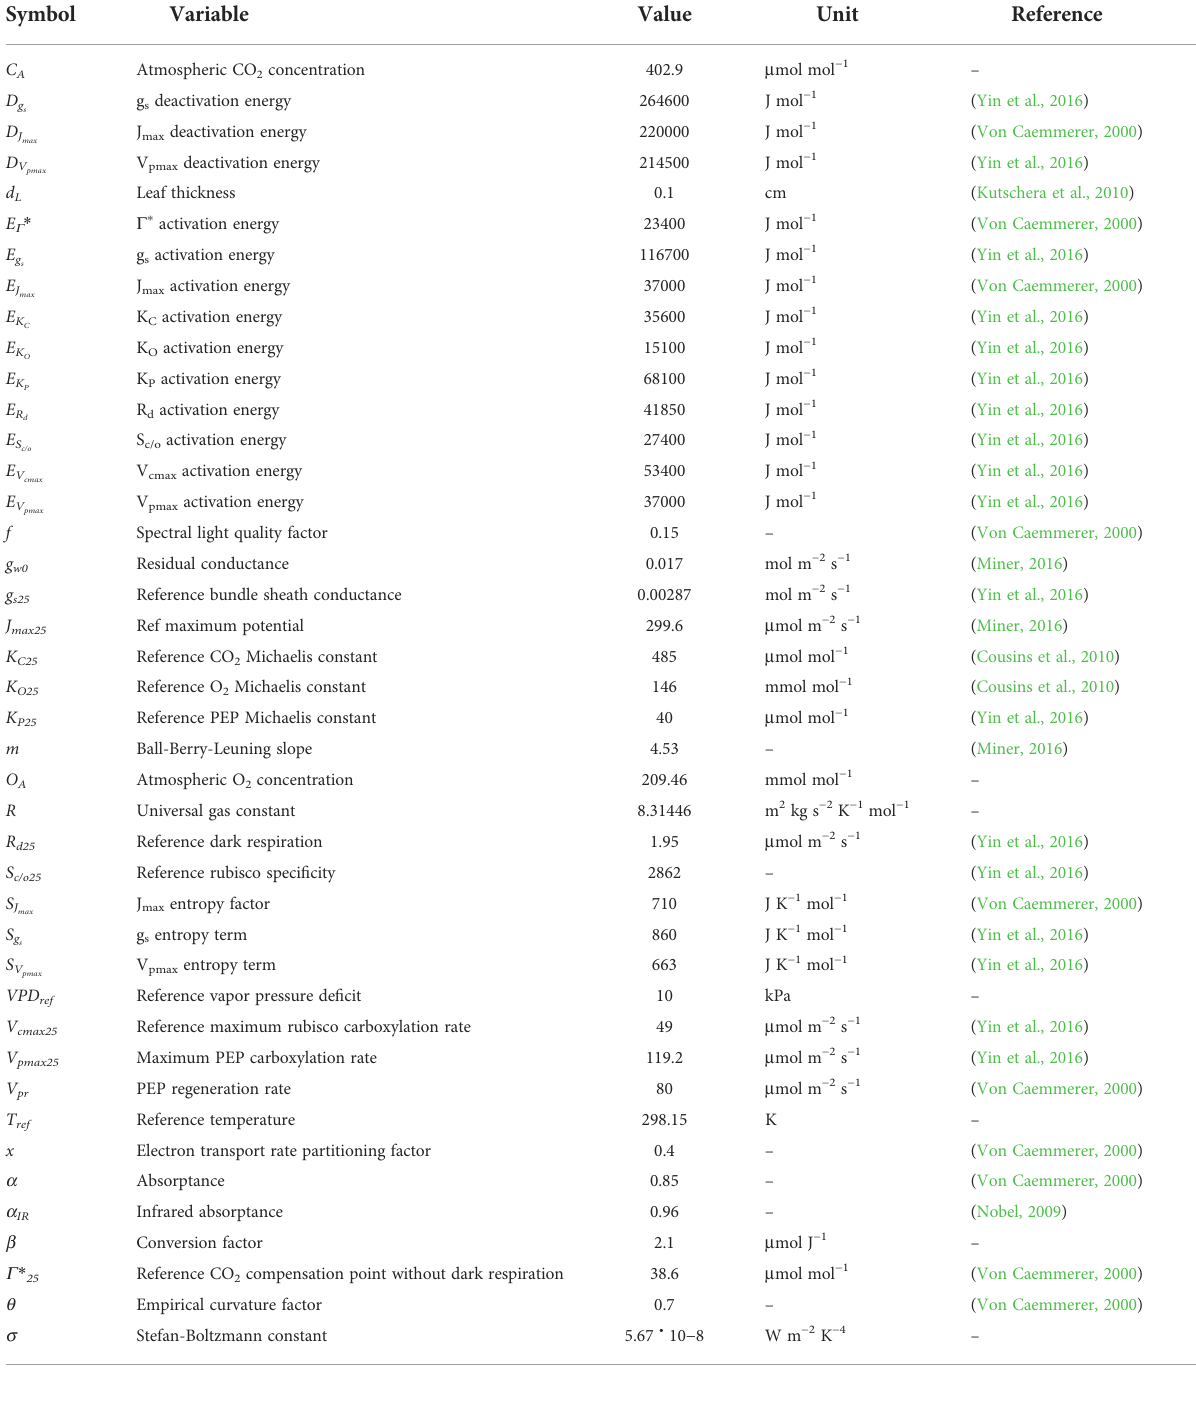
TABLE 3 Constants used in the model with the values used, units and references. Note that references are not provided for constants related to physics. Symbol Variable Value